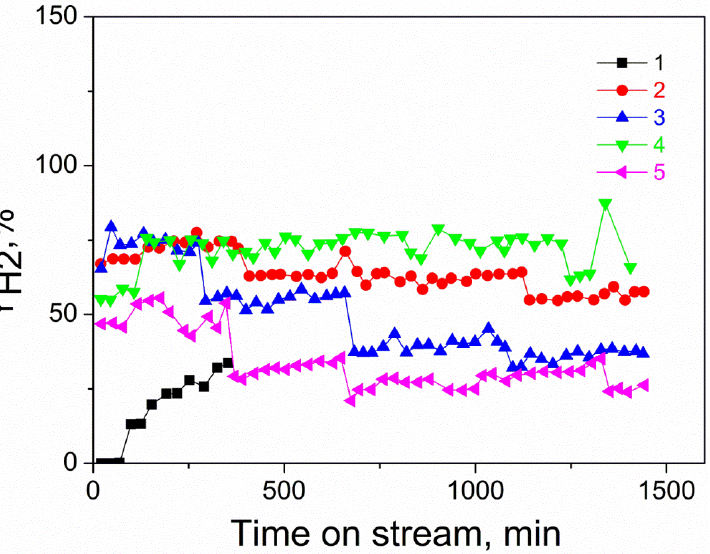
Figure 6. Hydrogen yield during CSMR at 750 °С. 1—Ni/CeMg-C-S-O; 2—Ni/CeMg-A-S-V; 3— Ni/CeMg-A-S-O; 4—Ni-Pd/CeMg-A-S-V; 5—Ni/CeMg-A-P-O.